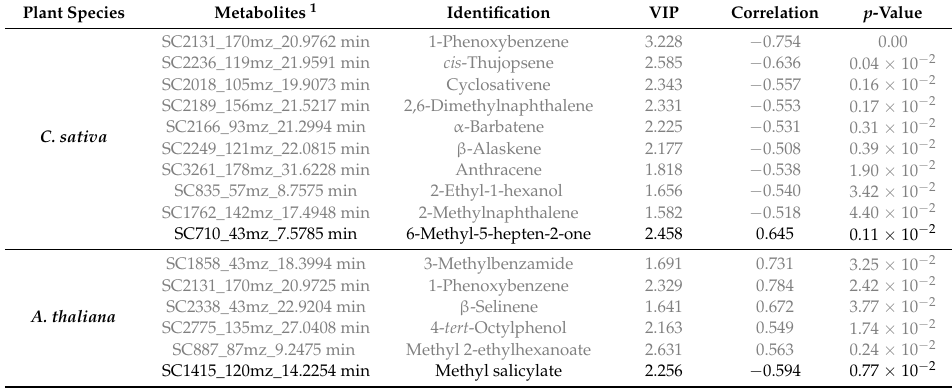
Table 1. Volatiles differentially emitted from C. sativa and A. thaliana TuYV-infected and non-infected